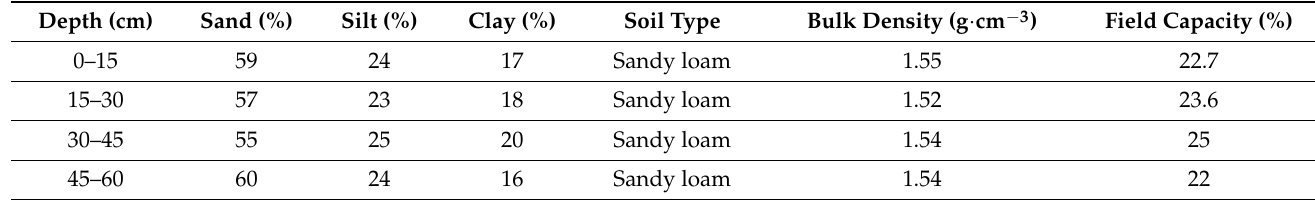
Table 3. Soil texture analysis, bulk density, and field capacity.